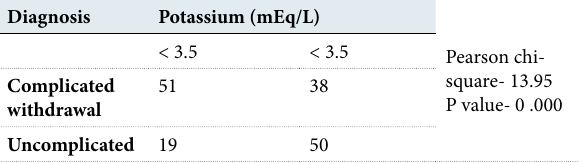
Table 3: Potassium value among complicated and uncomplicated alcohol dependence syndrome Diagnosis Potassium (mEq/L)